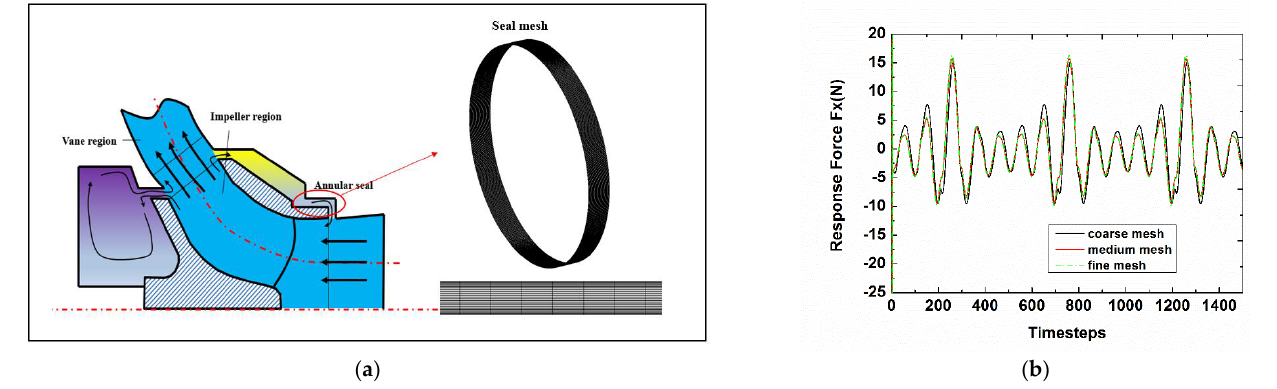
Figure 2. ( a ) Seal mesh; ( b ) Plots of mesh independence verification. Table 2. Mesh independence verification.